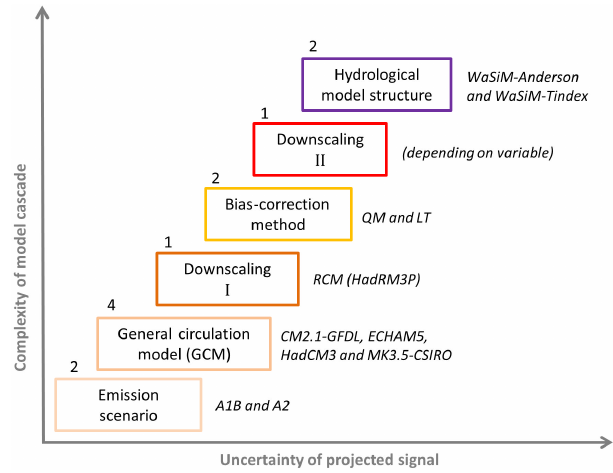
Figure 4. The model cascade is depicted with the individual mem- bers of each component listed on the right. Permuting the members of all components results in a total of 32 hydrological